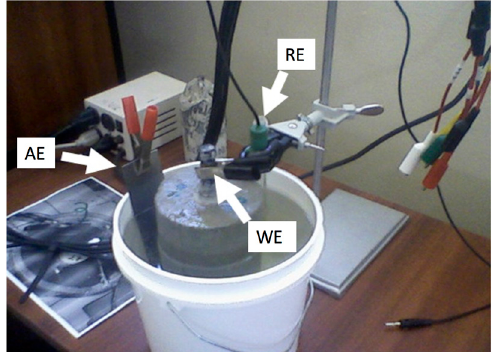
Figure 4. Experimental arrangement for the electrochemical tests. AE: auxiliary electrode; WE: working electrode; RE: reference electrode.